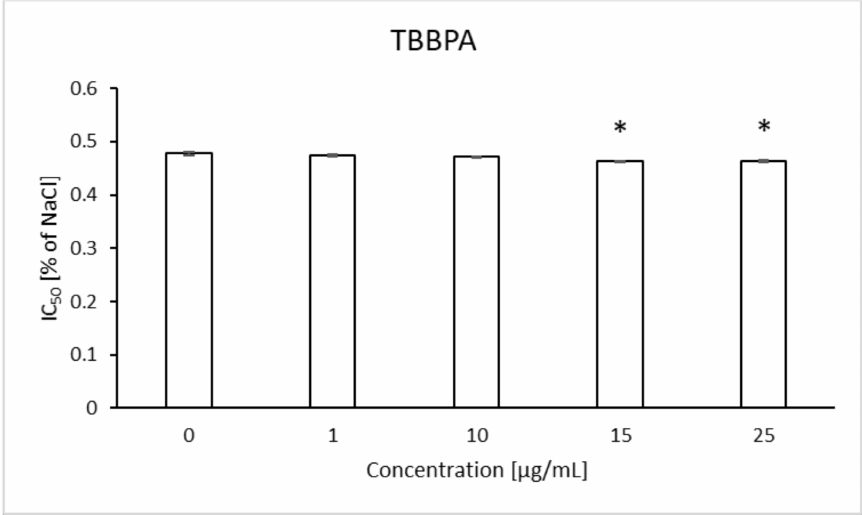
Figure 10. IC 50 parameter for control erythrocytes and erythroctes incubated with TBBPA at 1–25 µ g/mL for 3 h. (*) Significantly different from control ( p <